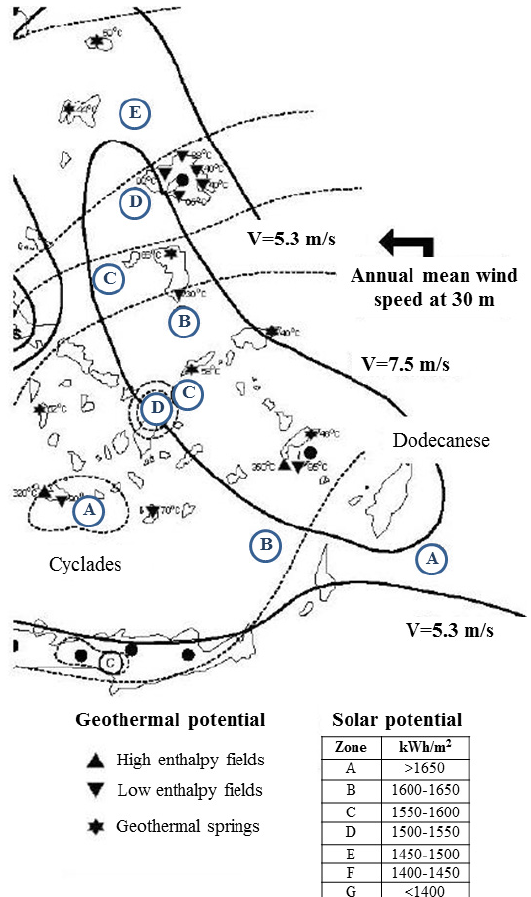
Figure 5. Renewable energy sources in Cyclades and Dodecanese. With permission of Manolakos (2012)